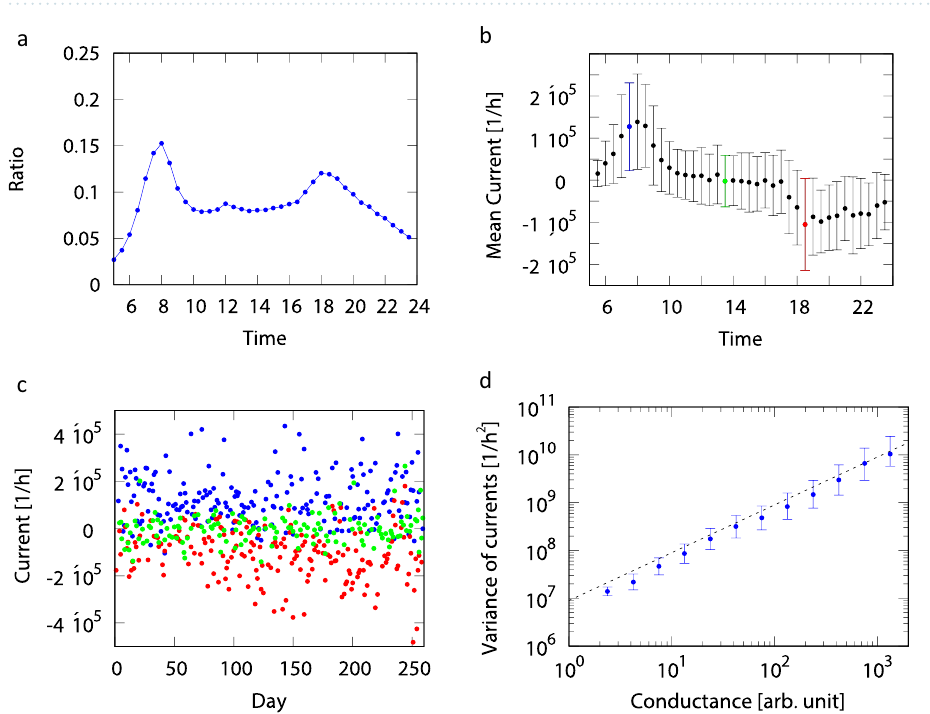
Figure 4. The relations between the variance of current and estimated conductance around Tokyo metropolitan area. ( a ) Ratio of moving people in the Tokyo metropolitan area by time of day. ( b ) Example of average current change in a cell during the day. Error bars represent standard deviation. ( c ) Weekday currents in the morning (blue), afternoon (green), and evening (red) of the cells noted in ( b ) are plotted daily. ( d ) Relationship between the variance of the current in each cell and the conductance with scaling exponent